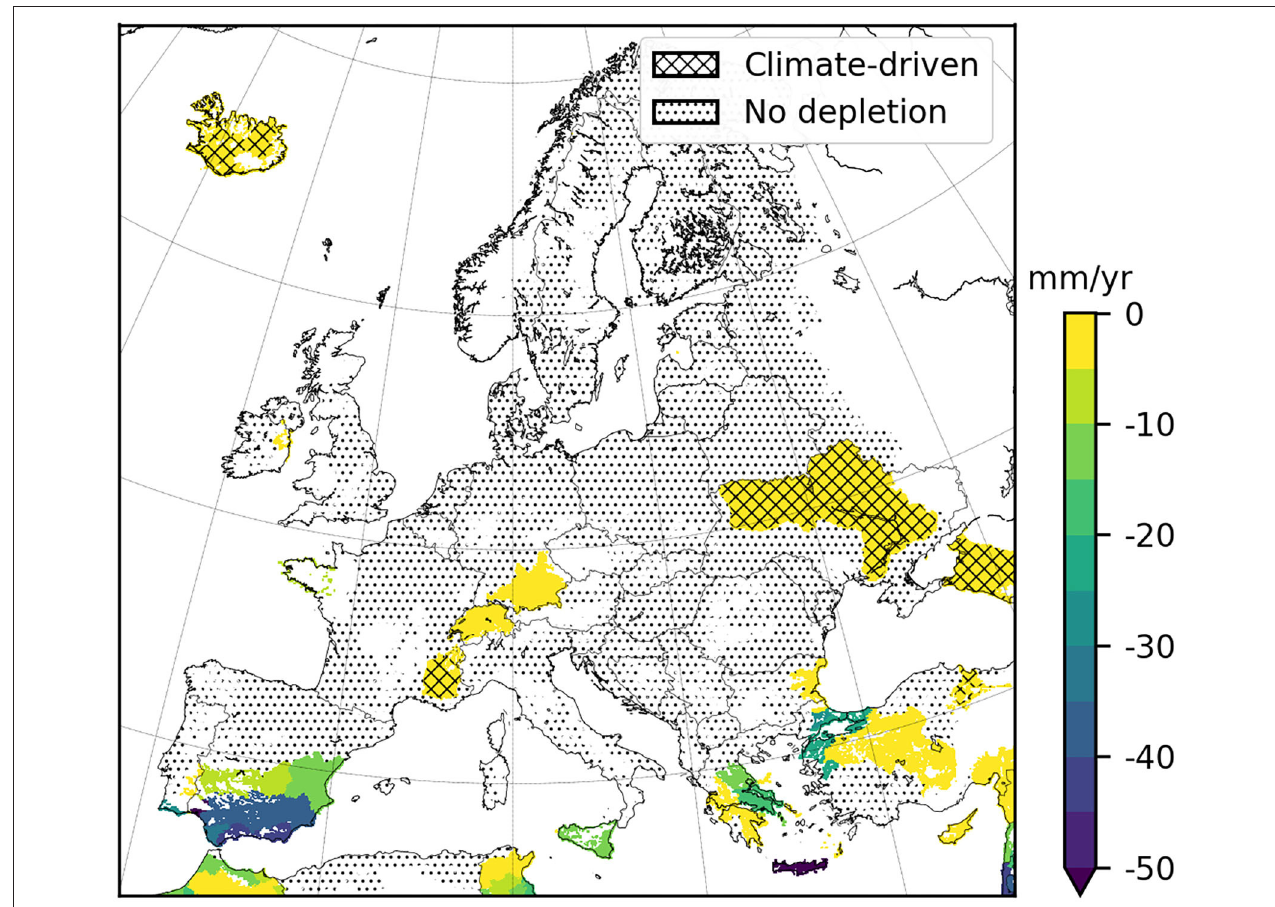
FIGURE 3 | Groundwater depletion between 2018 and 1990, as estimated with the LISFLOOD model (from Gelati et al.,